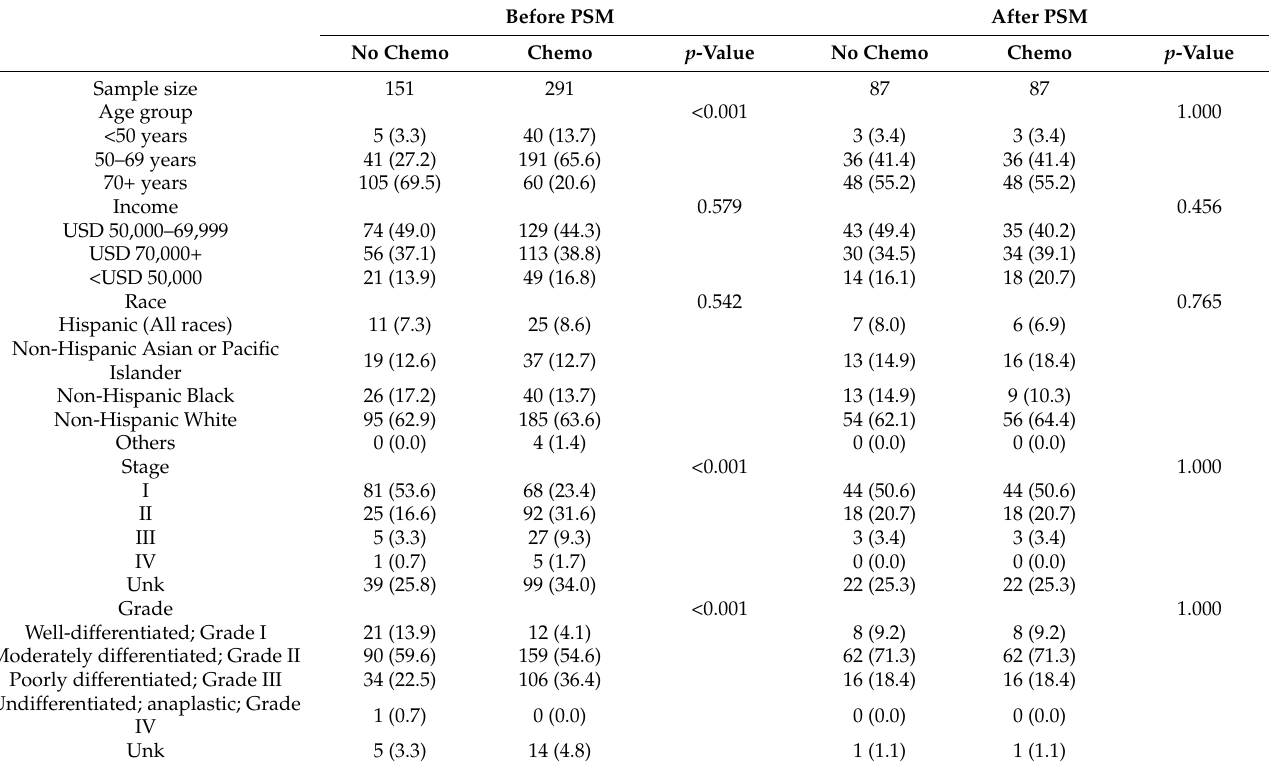
Table 4. Baseline information of TNAC patients from the SEER database. Before PSM After